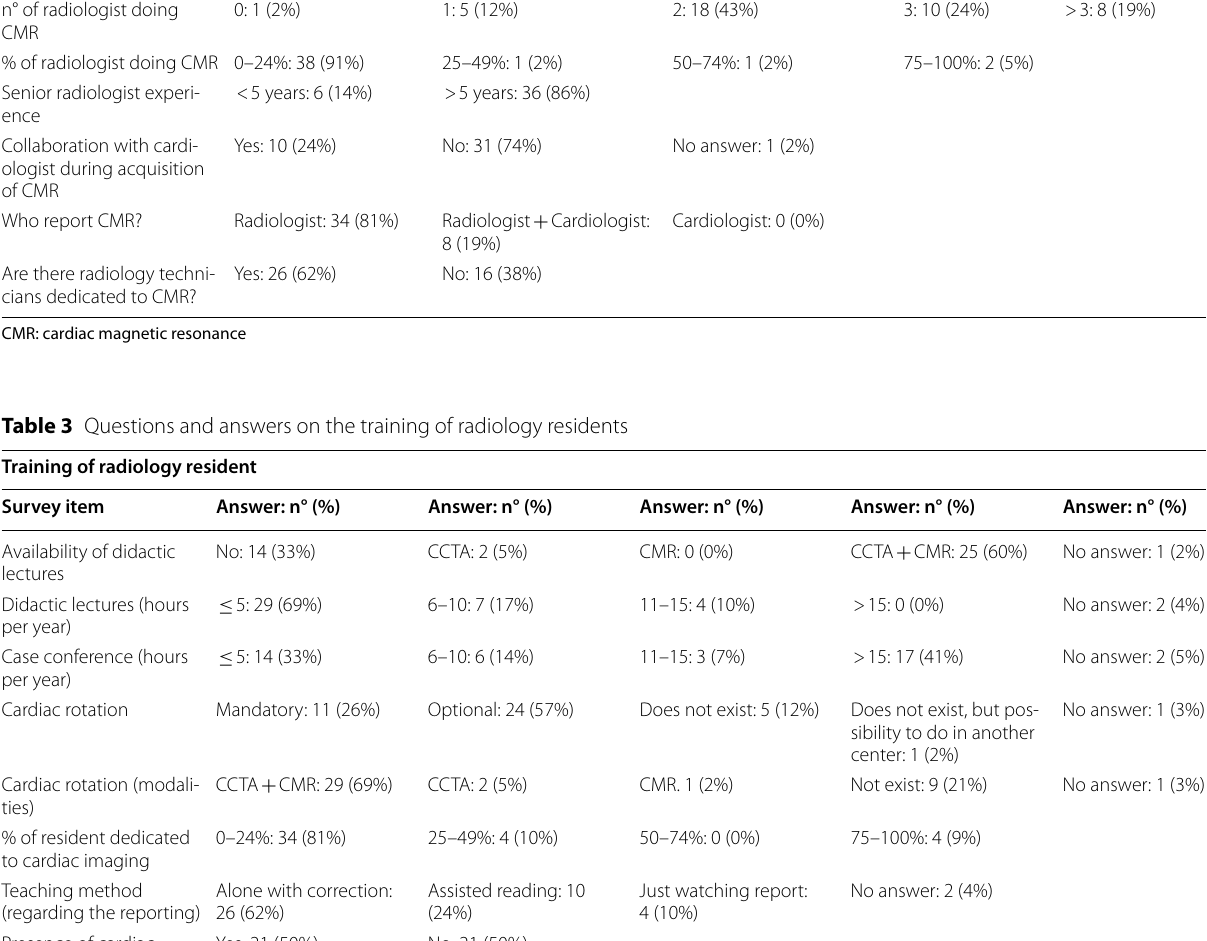
Table 4 details the answers to the 10 questions regard-